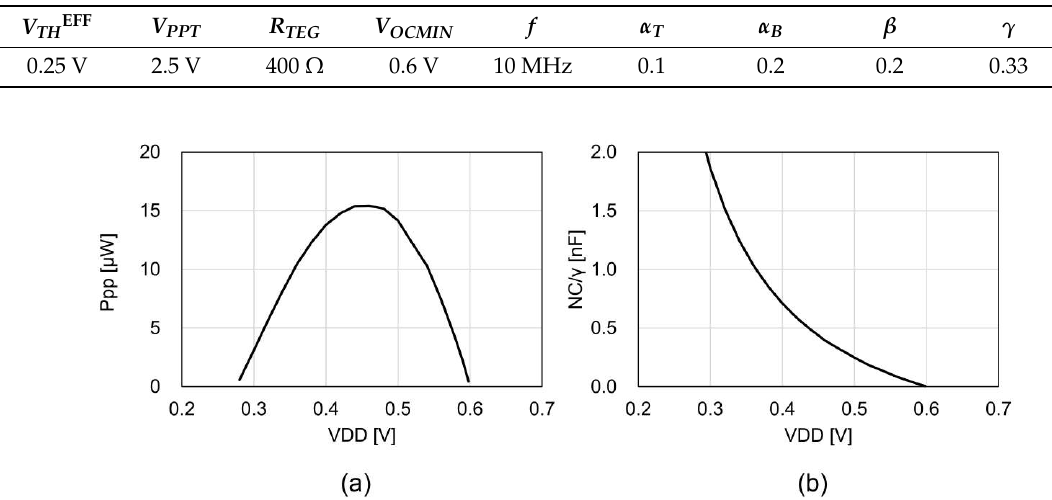
Table 3. Design parameters used in this work.